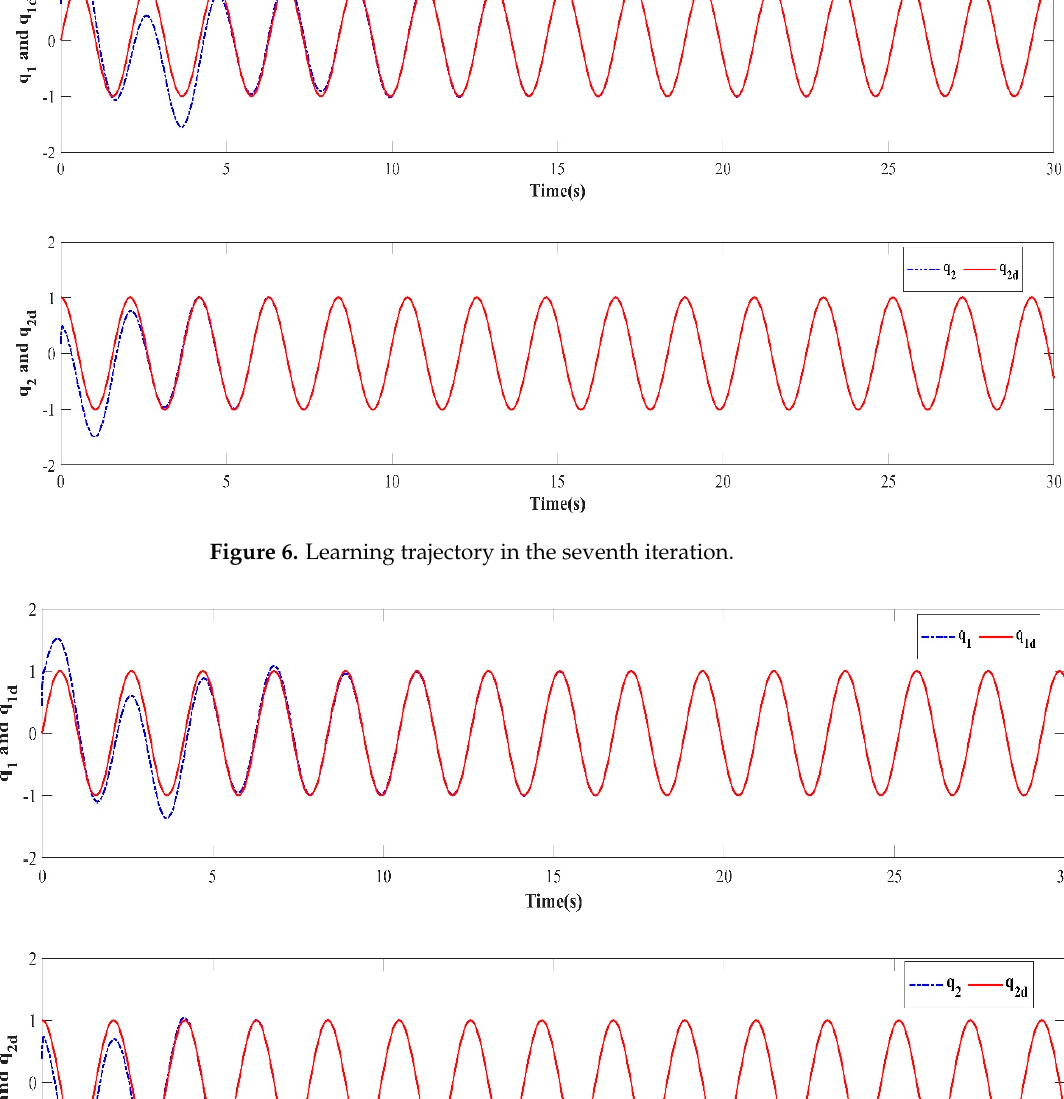
Figure 5. Learning trajectory in the fifth iteration.